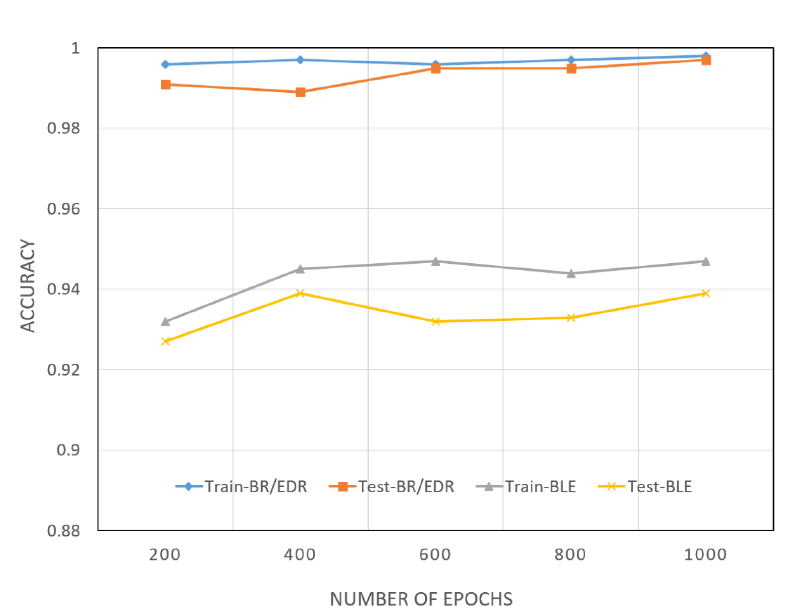
Figure 9. Training and testing accuracy. The proposed IDS DNN model for the BR/EDR and BLE datasets for 1000 epochs attained an accuracy of 98%.